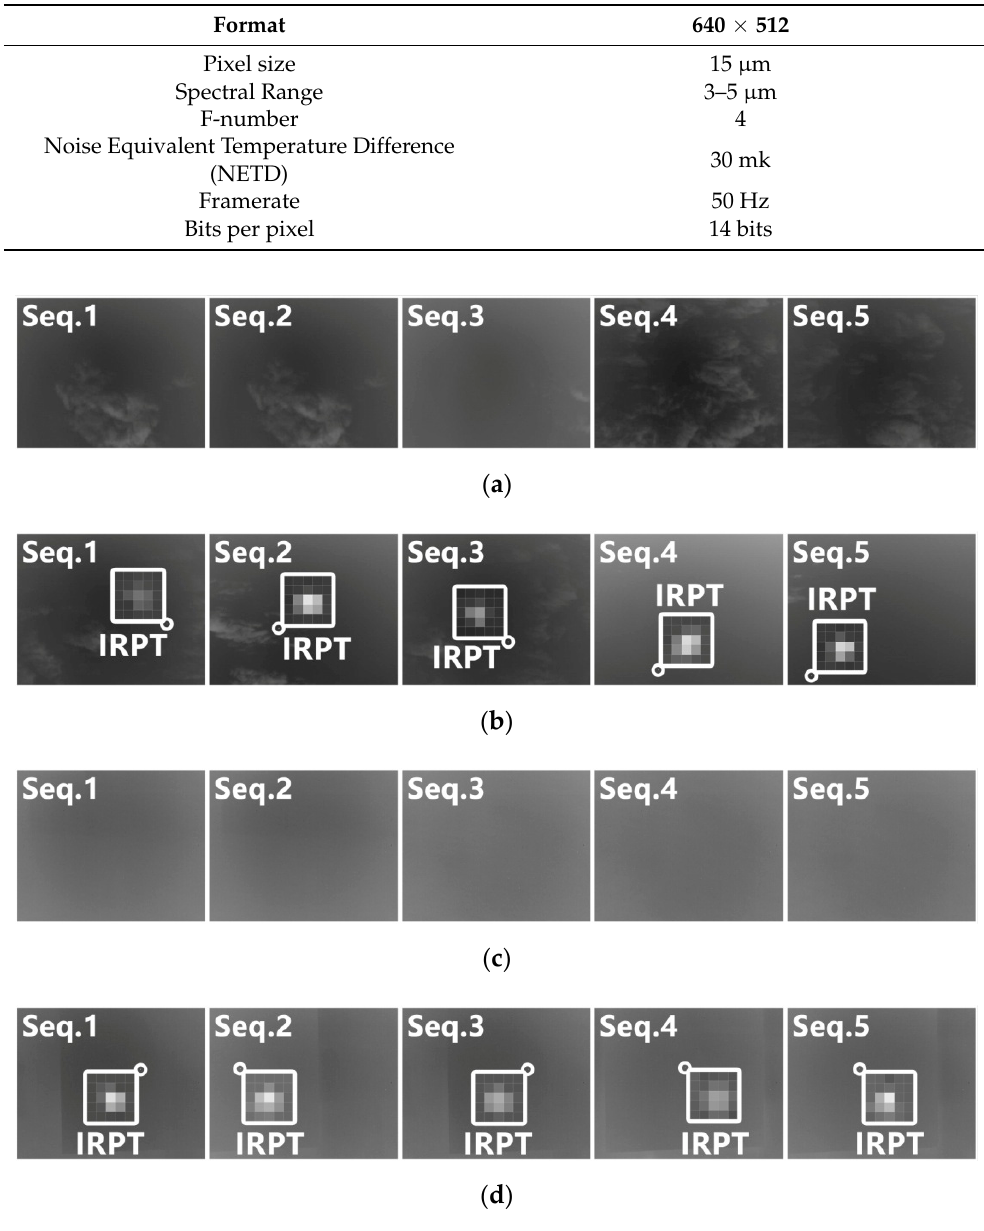
Figure 5. The real experimental data ( a ) sky background, ( b ) sky background with IRPT, ( c ) space background, ( d ) space background with IRPT.